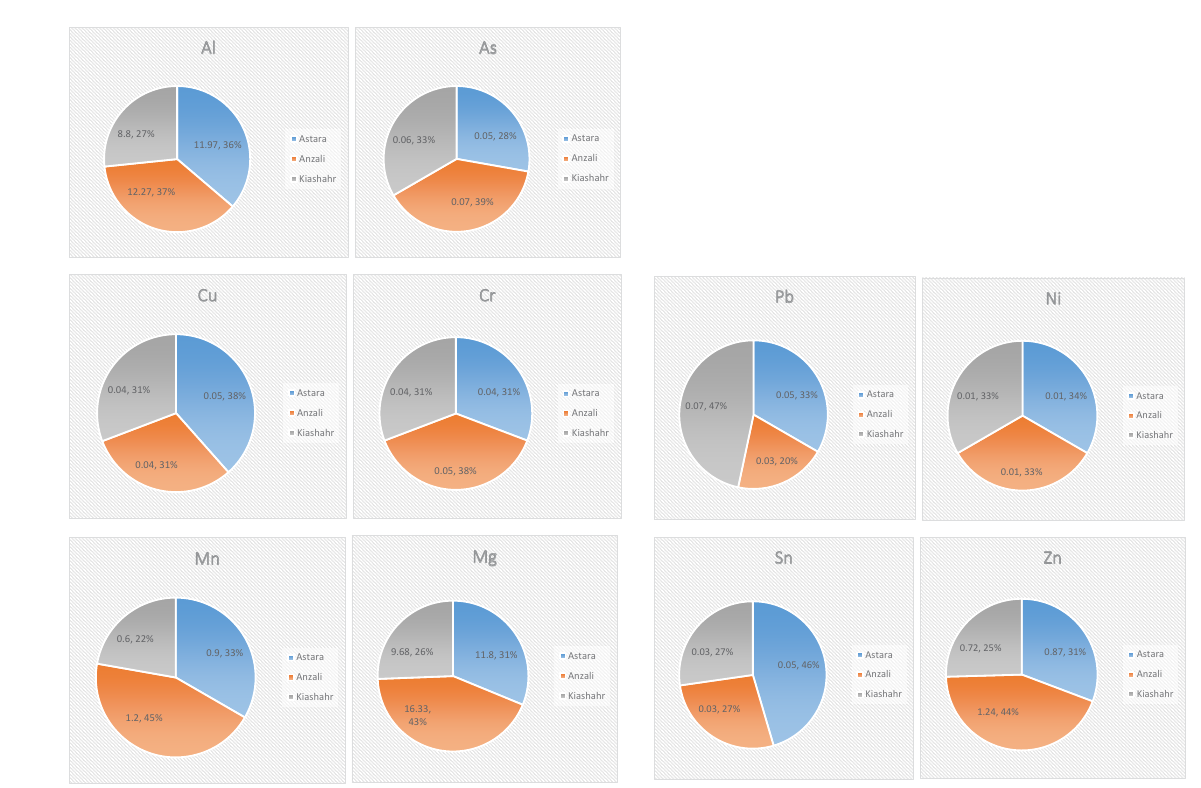
Fig. 5. Comparison of the elements in sampling areas Among the studied elements, the important elements mentioned in other studies, including Al, As, Cu, Cr, Mn, Mg, Pb, Ni, Sn, and Zn were compared. As shown in Figure 5, the highest levels of As, Al, Cr, Mg, Mn, and Zn were observed in Anzali. The highest amount of Cu, Ni, and Sn was reported in Astara, while the highest amount of Pb was determined in Kiashahr. Based on these results, Anzali was the most polluted area in terms of observed elements. Anzali port is in a better commercial and fishing position than the other two areas. The presence of shipping and fishing industries in Anzali has increased pollution in this area.